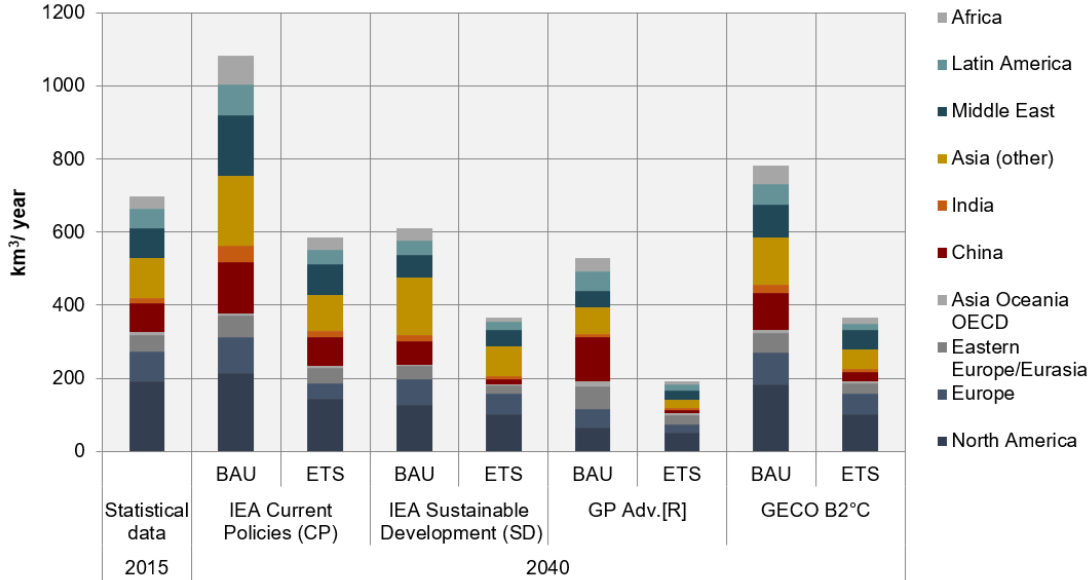
Figure 8. Water withdrawal for electricity generation (in km³ per year, excluding hydropower) by region in 2015 and the four energy scenarios in combination with changes in the power plant type and cooling technologies (BAU and ETS scenarios) in 2040. (Source: own calculation based on the data from [39–41]).